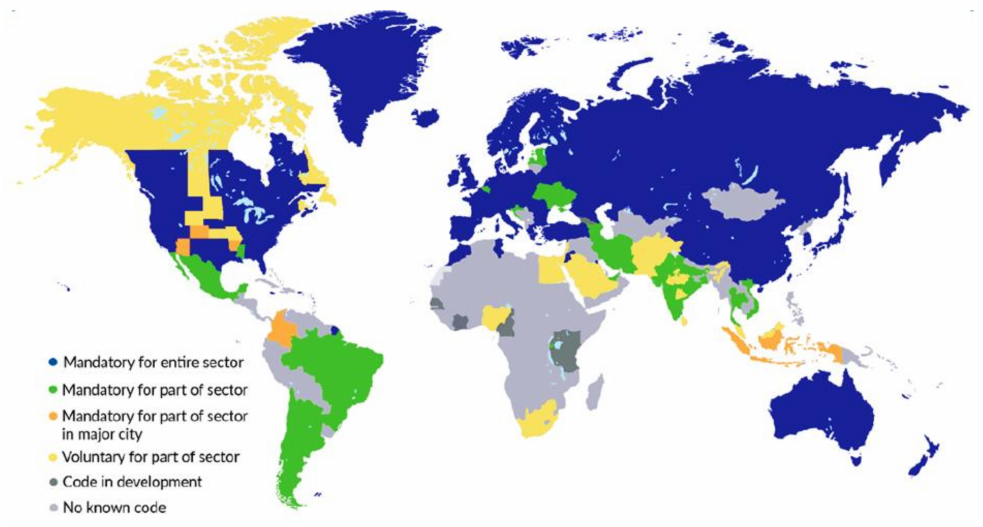
Figure 1. Building energy code by jurisdiction, 2018–19 (IEA, All right reserved) [8]. Note—this map is without prejudice the status of or sovereignty over any territory, to the delimitation of international frontiers and boundaries and to the name of any territory, city or